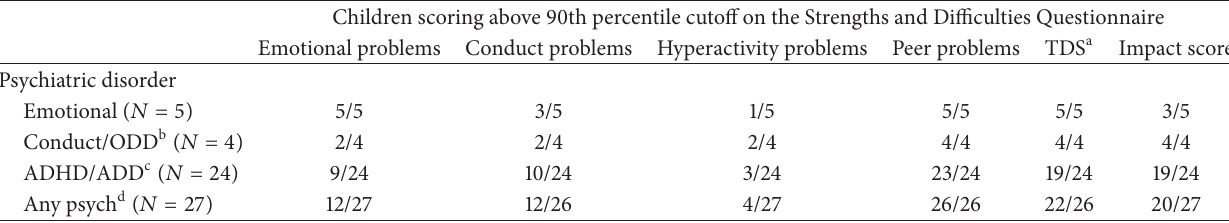
Table 3: Coexisting mental health symptoms in children with cerebral palsy meeting criteria for a psychiatric disorder according to DSM-IV criteria assessed by